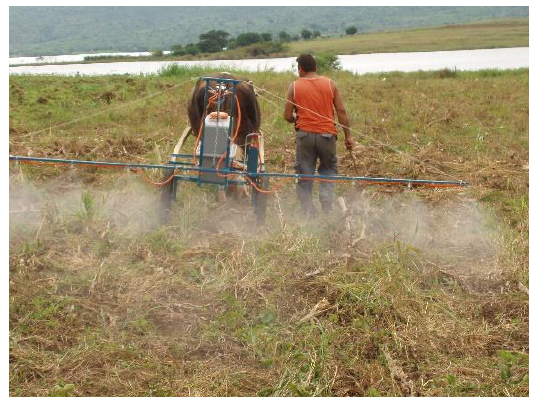
Figure 1. Draft animal powered boom sprayer.